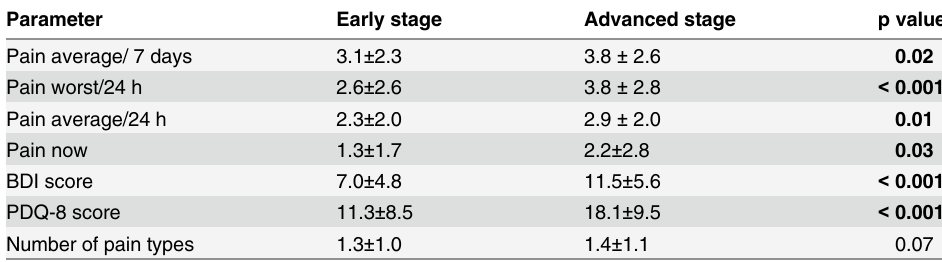
Table 4. Comparison of early and advanced stages of PD.